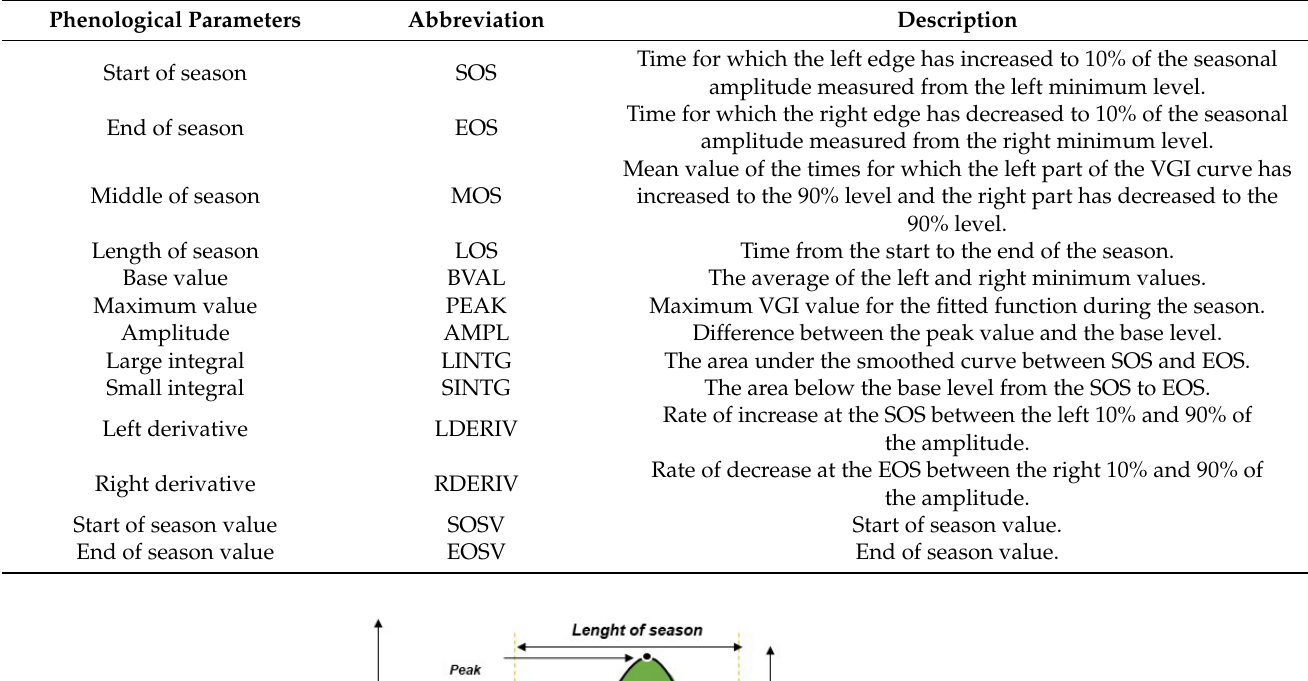
The average of the left and right minimum values.